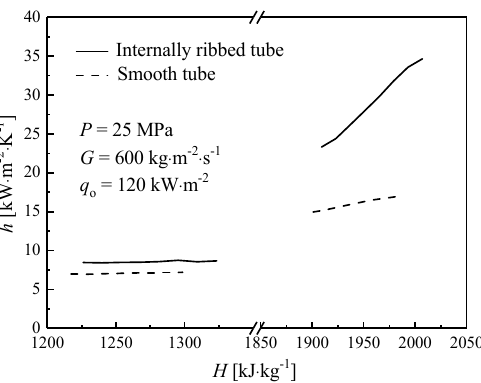
Figure 7. Variation of heat transfer coefficient (HTC) in different enthalpy regions. At low enthalpy region, the HTC of IRT is slightly higher than that of ST under the same enthalpies. However, when the bulk enthalpy enters into the pseudocritical region (about 1900–2300 kJ/kg), the difference of the averaged HTC between IRT and ST increases sharply, and the ratio IRT to ST is about 1.81, where the ratio is only 1.21 in the low-enthalpy region. Obviously, IRTs exhibits outstanding heat transfer capability in the pseudocritical